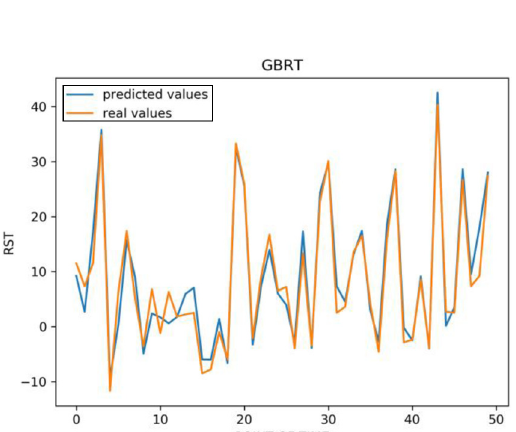
Figure 9. Regression plot for data samples of GBRT